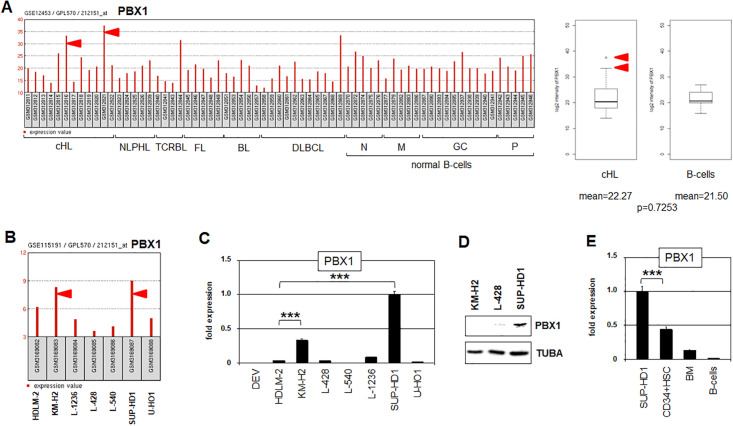
PBX1 expression in HL patients and cell lines.(A) PBX1 expression levels in HL patients according to dataset GSE12453 (left). Statistical analysis of PBX1 expression in cHL patients and normal B-cells using dataset GSE12453. The red arrow heads indicate two patients with highest PBX1 levels. Overall the difference between patients and controls is not significant (right). BL: Burkitt lymphoma, cHL: classical HL, DLBCL: diffuse large B-cell lymphoma, GC: germinal center B-cells, FL: follicular lymphoma, M: memory B-cells, NLPHL: nodular lymphocyte-predominant HL, N: naïve B-cells, P: plasma B-cells, TCRBL: T-cell rich B-cell lymphoma. (B) PBX1 expression levels in HL cell lines according to dataset GSE115191. KM-H2 and SUP-HD1 showed the highest PBX1 levels. (C) RQ-PCR analysis of PBX1 in HL cell lines, confirming enhanced transcript levels in KM-H2 and SUP-HD1. (D) Western blot analysis of PBX1 in HL cell lines showing PBX1 protein in SUP-HD1 but not in KM-H2. TUBA served as loading control. (E) RQ-PCR analysis of PBX1 in HL cell line SUP-HD1 in comparison to primary cells: hematopoietic stem cells (HSC), bone marrow (BM), and peripheral B-cells.